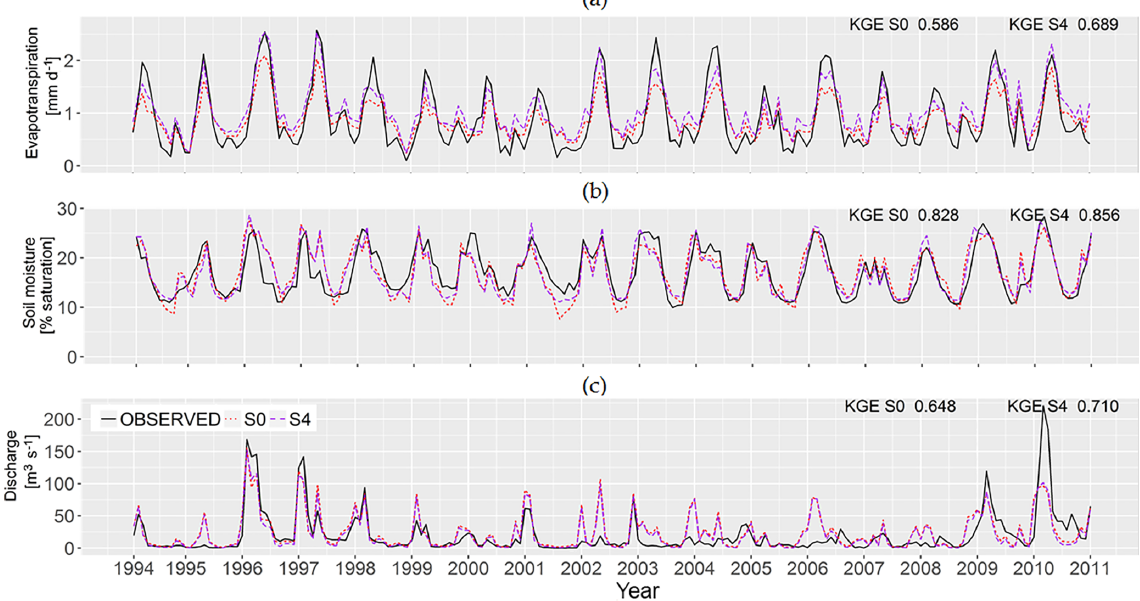
Figure 7. (a) Monthly GLEAM actual evapotranspiration (black) and estimated actual evapotranspiration (red and purple) time series over the entire Oum er Rbia basin. (b) Monthly ESA CCI soil moisture (black) and estimated soil moisture (red and purple) time series over the entire Oum er Rbia basin. (c) Monthly observed discharge (black) and estimated discharge (red and purple) time series at Mechra Eddahk. The red dashed lines represent estimates from calibration scenario S0 (reference scenario). The purple dashed lines represent the calibrated time series from calibration scenario S4 which are taken from the runs that yield the best simulations. Estimated time series over the entire Oum er Rbia basin for the validation time period obtained with MSWEP precipitation are